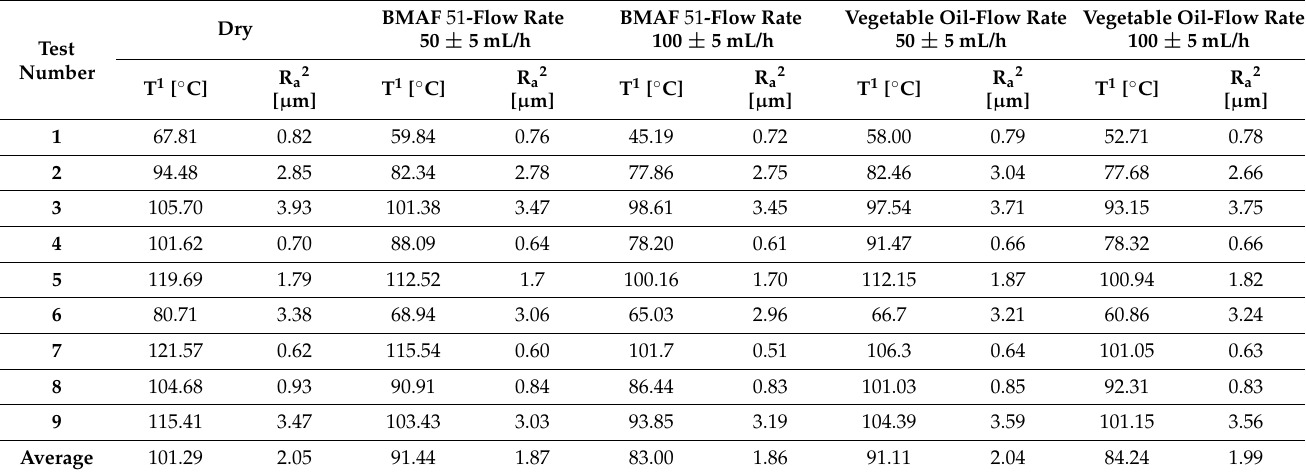
Table 4. Experimental results of average of Ra measurements and chip